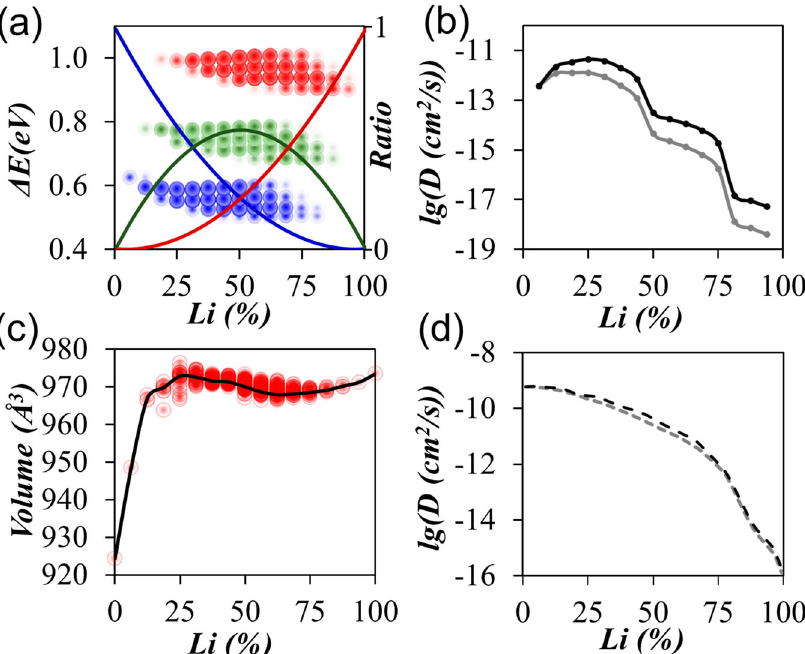
Fig. 5 Li-ion diffusion characteristics of Li x TiS 2 . a Distribution of the Li-ion diffusion energy barriers depending on the Li content. The curves show the fraction of the available pathways. Blue, green, and red colors correspond to 3-, 2-, and 1-vacancies pathways, respectively. Trace (gray curve) and jump (black curve) diffusion coef fi cient as a function of the Li content computed in this work ( b ) and in ref. 46 ( d ). Unit cell volume as a function of the Li content ( c ), where the black curve shows Boltzmann ’ s average